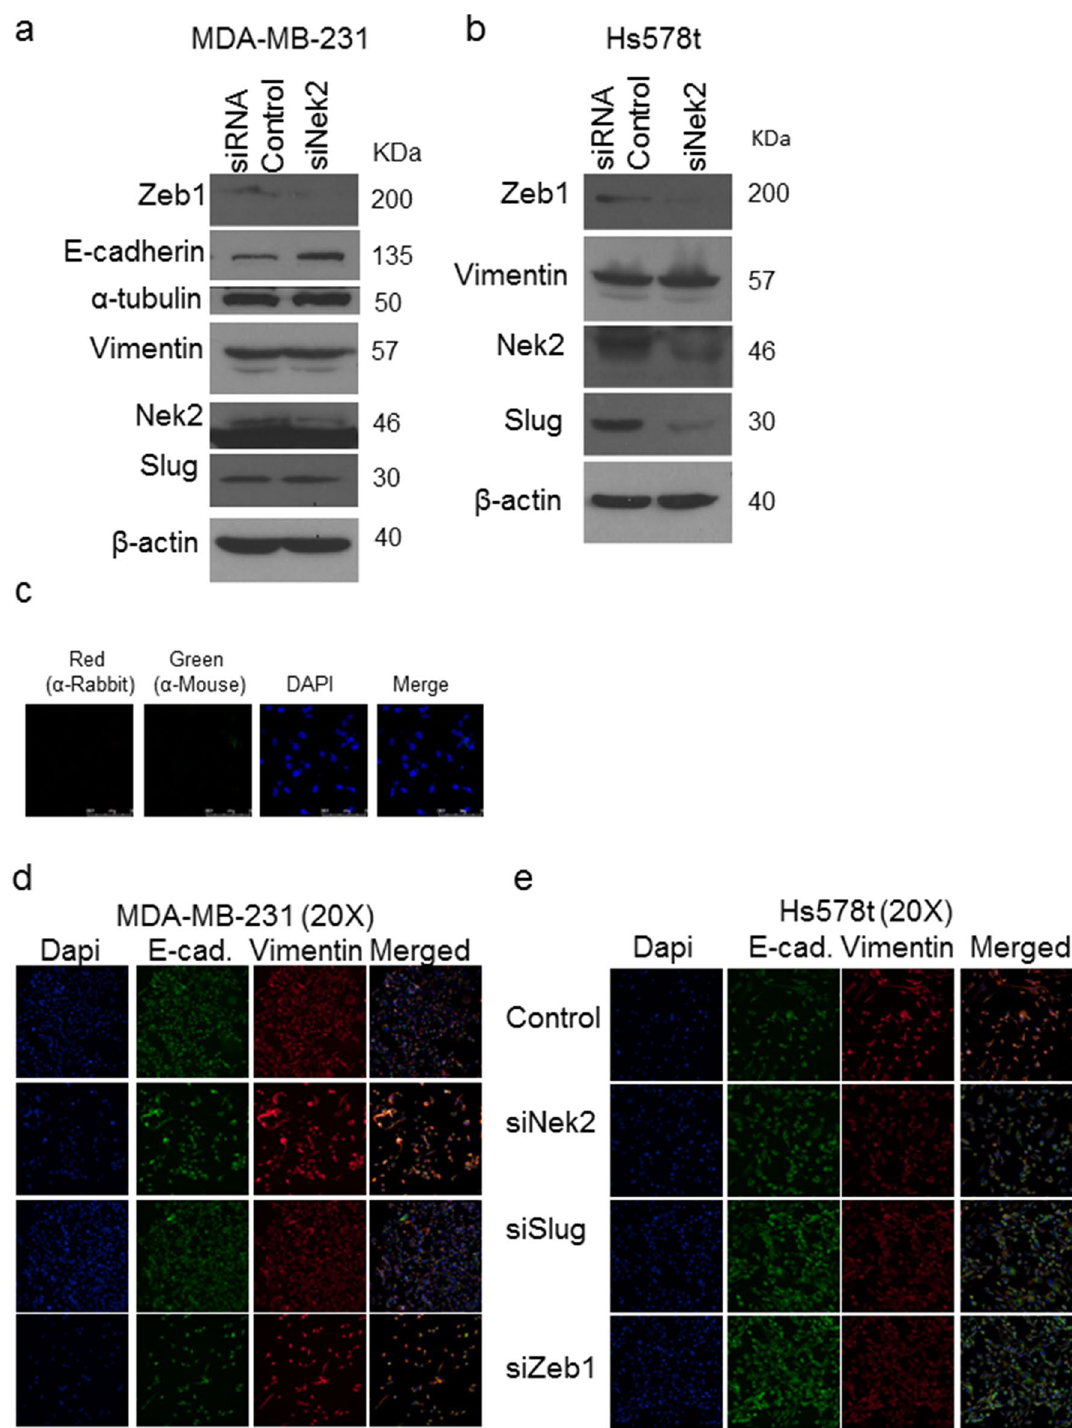
Figure 4. Nek2 maintains the mesenchymal state in triple-negative breast cancer cells. ( a,b ) Immunoblots of EMT pathway markers in MDA-MB-231 treated with 50 nM siNek2 5-siRNA pools (Dharmacon) in MDA-MB-231 cells ( a ) and Hs578t cells ( b ). ( c ) Immunofluorescence controls with secondary antibodies. ( d,e ) Co-Immunofluorescent staining of E-cadherin (green) and Vimentin in MDA-MB-231 cells ( d ) or Hs578t cells ( e ), in cells transfected with 50 nM of the indicated 5-siRNA pools (Dharmacon). Nucleus was counterstained with DAPI